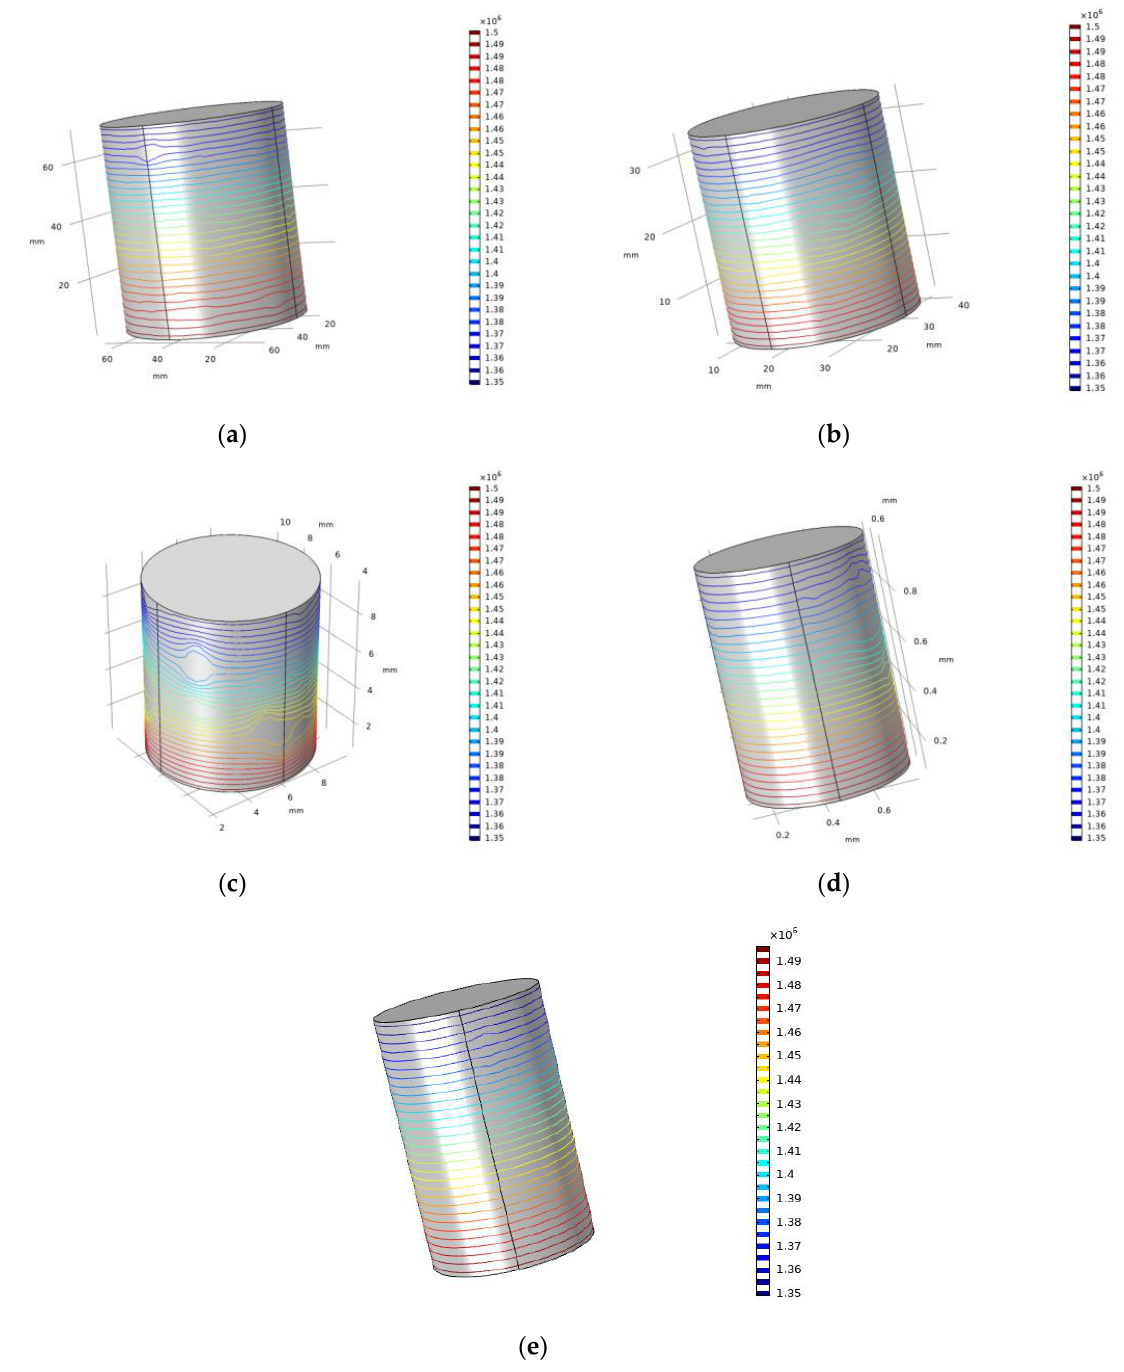
Figure 13. Pore pressure distribution diagram (unit: Pa). ( a ) Sample C1; ( b ) Sample C2; ( c ) Sample C3; ( d ) Sample C4; ( e ) Sample C5. Table 3. Comparison between simulated results of core permeability and experimental results.